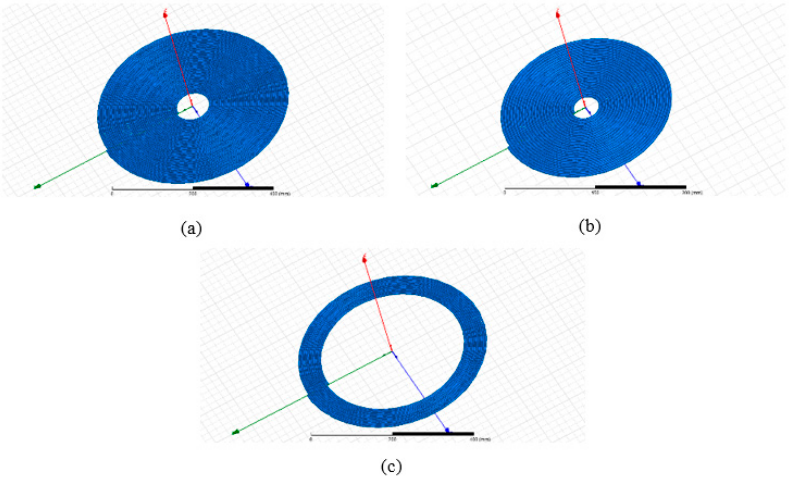
Figure 15. Images of the created coils using Ansys/Maxwell Software: ( a ): Coil1, ( b ): Coil2 and ( c ): Coil3.